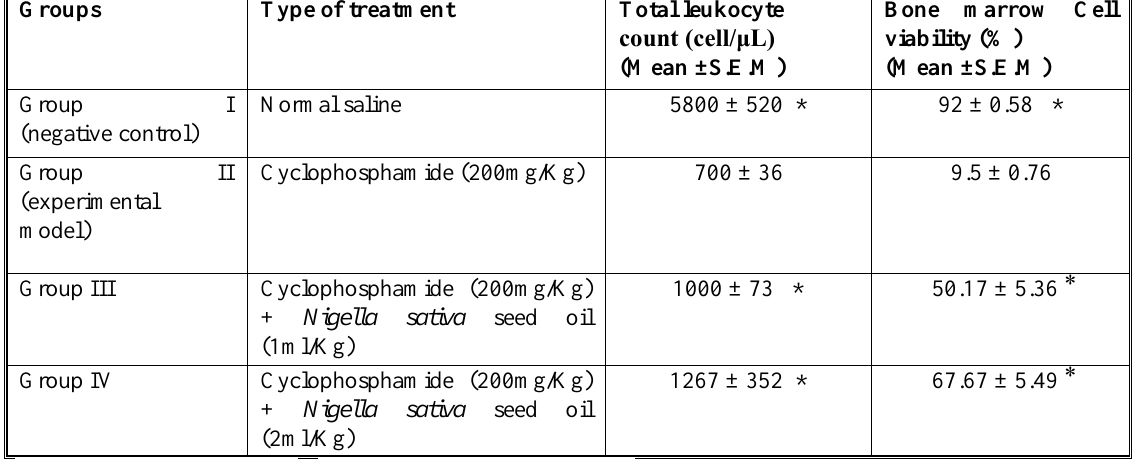
Table 1. Effects of Nigella sativa seed oil on total leukocytes count and bone marrow cells viability in cyclophosphamide-induced myelosuppresion in mice.